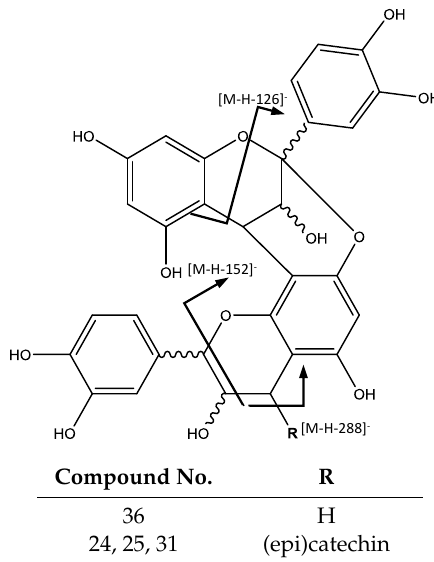
Figure 4. Proanthocyanidin A-type structure and main